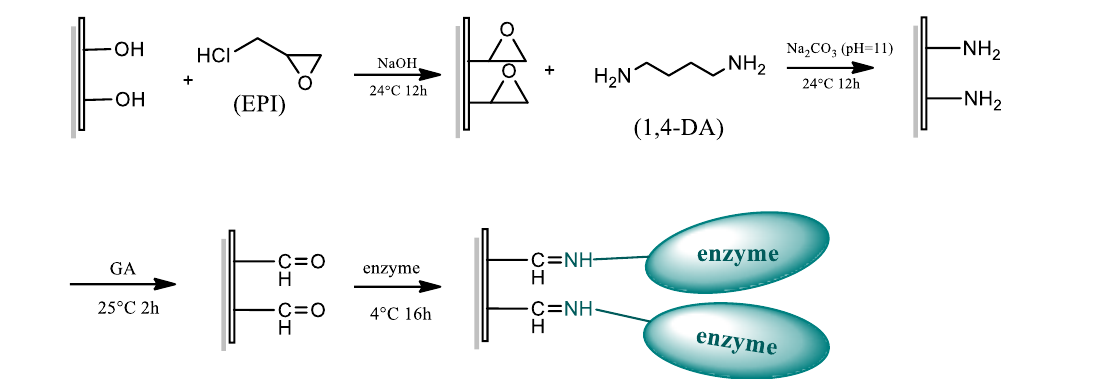
Scheme 2. RC-EPI-DA-GA membrane